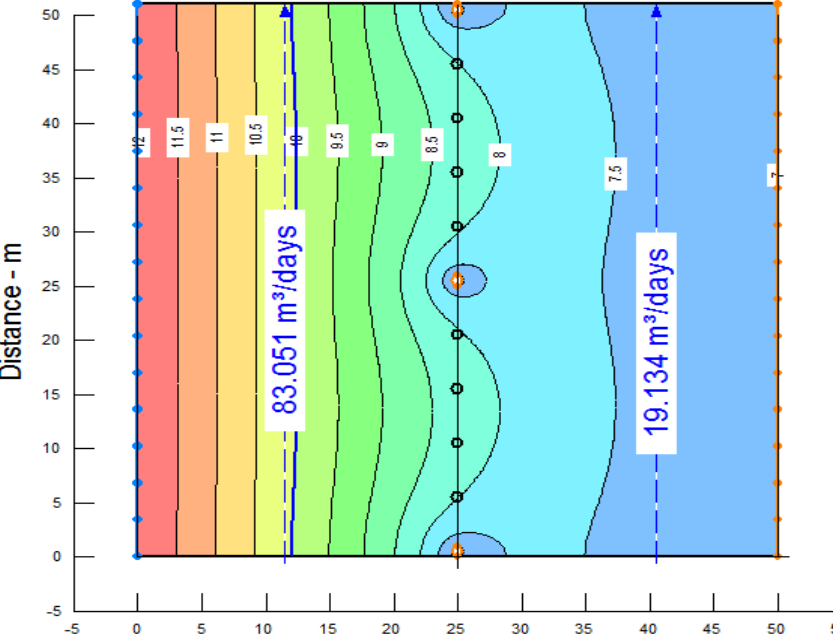
Fig. 8. Relief wells plan at toe of earth dam by 0.5 m radius and 25 m distance from each other.